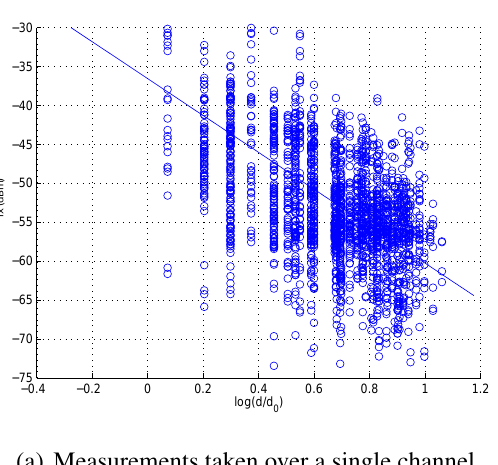
Figure 9. RSSI measurement campaigns for channel parameter